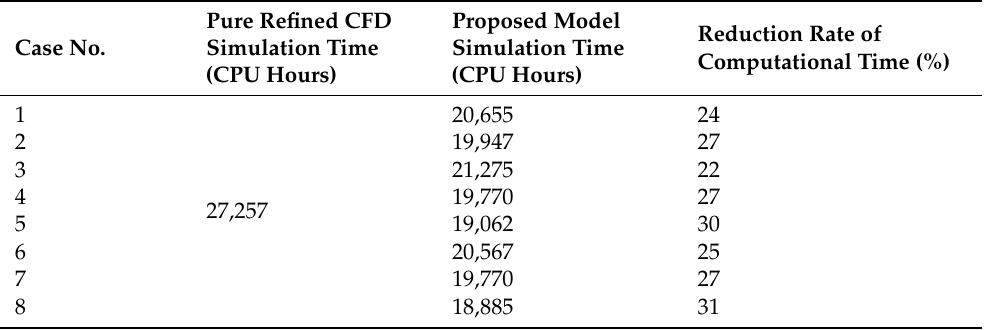
Table 8. Comparison of the computational time for pure refined CFD and the proposed model (6 training data points).